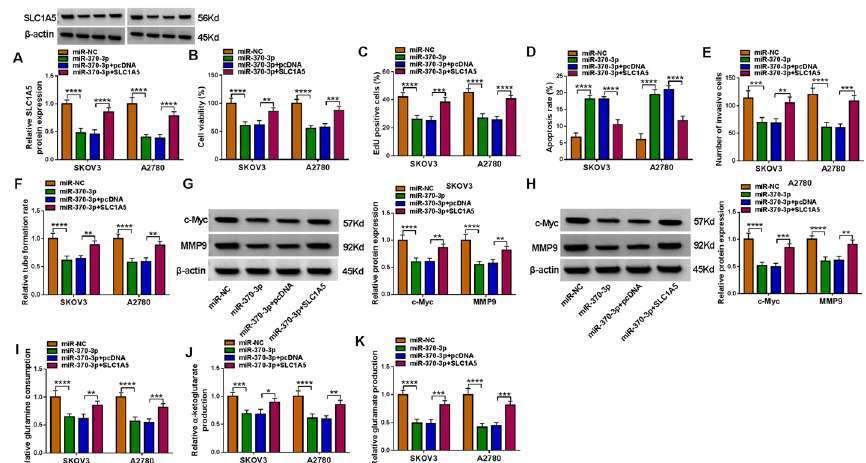
Fig. 6 hsa_miR-370-3p negatively regulated SLC1A5 . A – K SKOV3 and A2780 cells were transfected with miR-NC, hsa_miR-370-3p, hsa_miR-370-3p pcDNA, or hsa_miR-370-3p SLC1A5 . A SLC1A5 protein + + expression was examined using western blot. B and C CCK-8 and EdU assays assessed proliferation